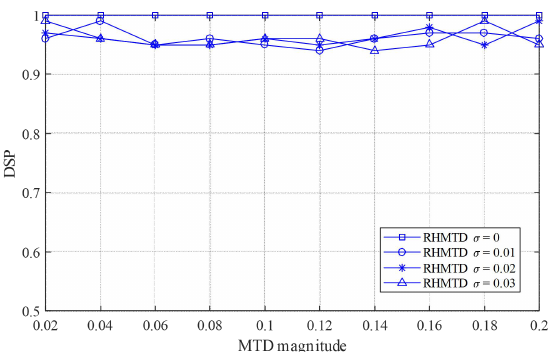
Figure 8. The hiddenness of RHMTD against the model-based alert attacker under noiseless and noise conditions.